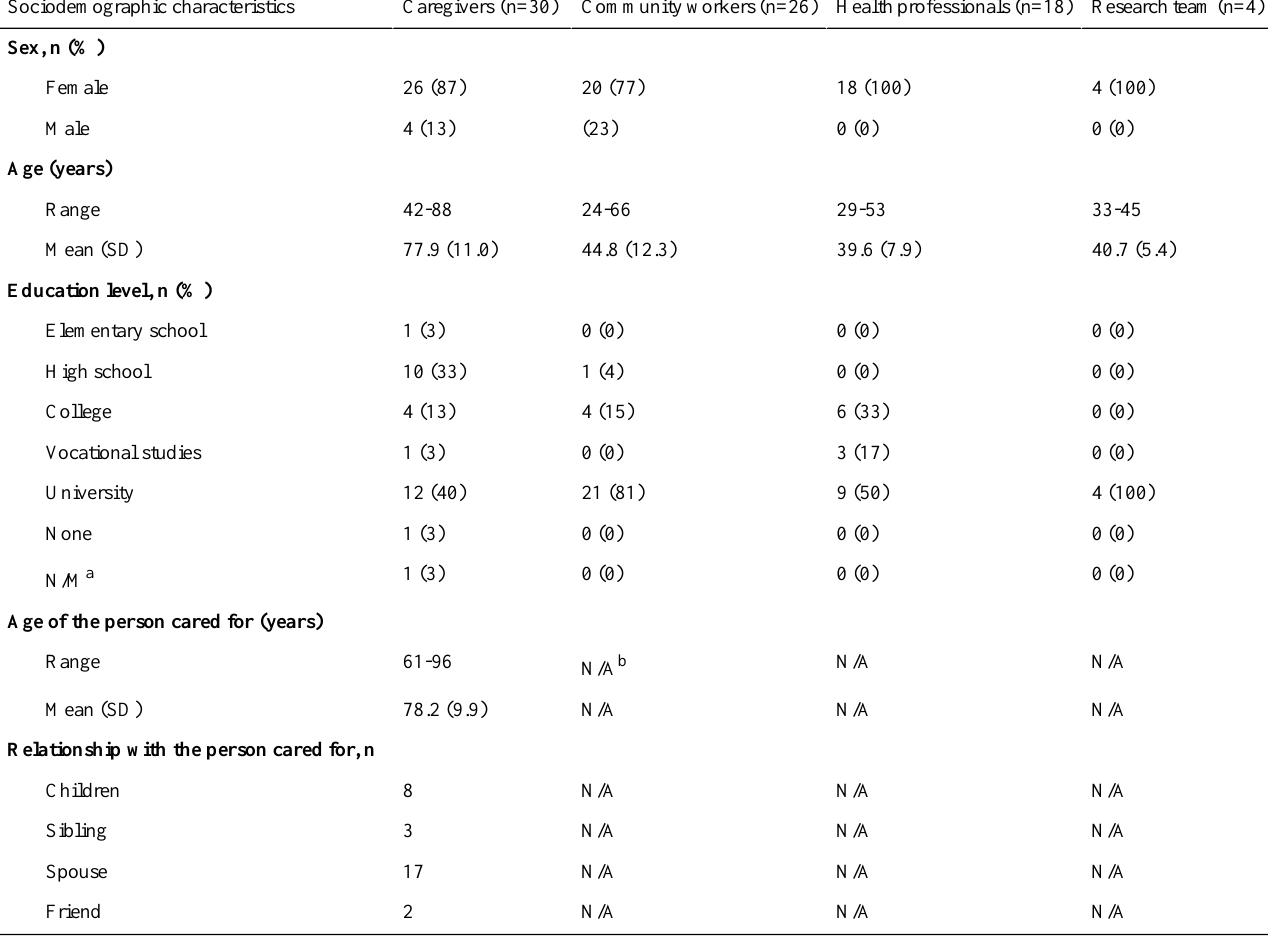
Table 2. Description of co-designers